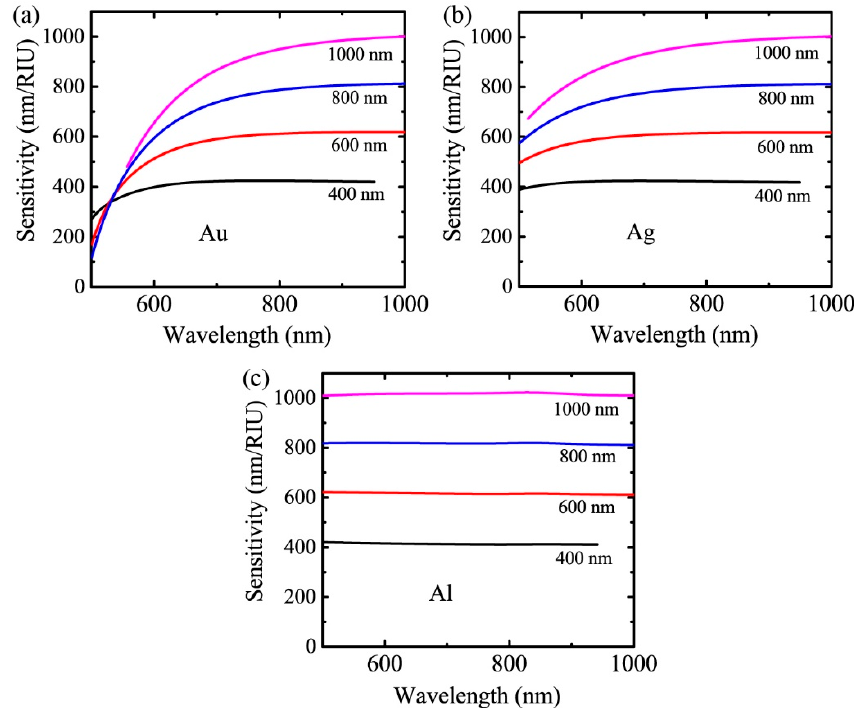
Figure 3. The theoretical sensitivity of the grating-based sensor as a function of the wavelength for four different periods with n a = 1.34, m = 1. The materials for the gratings are ( a ) Au, ( b ) Ag, and ( c ) Al, respectively.